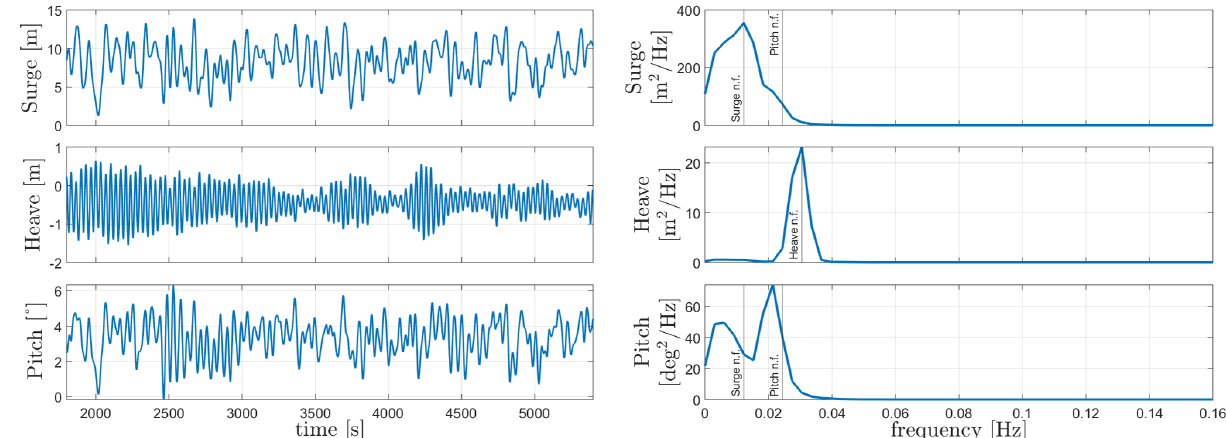
Figure 13. WindCrete response to ETM wind and NSS ( T p = 6s ,H s =